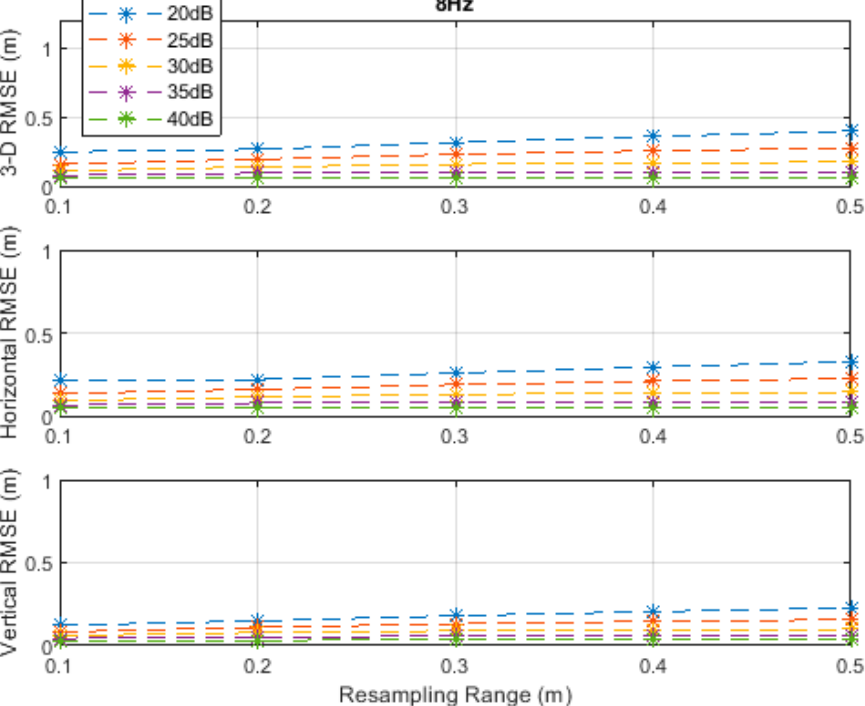
Figure 12. RMSE results along the horizontal circular path at a measurement update rate of 8 Hz.